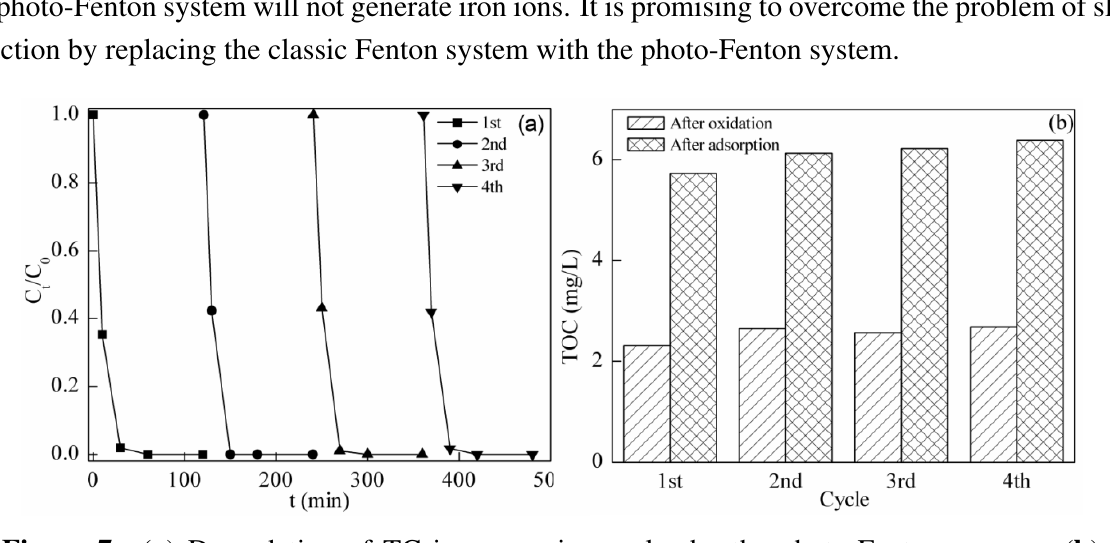
Figure 7. ( a ) Degradation of TC in successive cycles by the photo-Fenton process; ( b ) Residual TOC concentration after adsorption and the photo-Fenton process of each cycle.